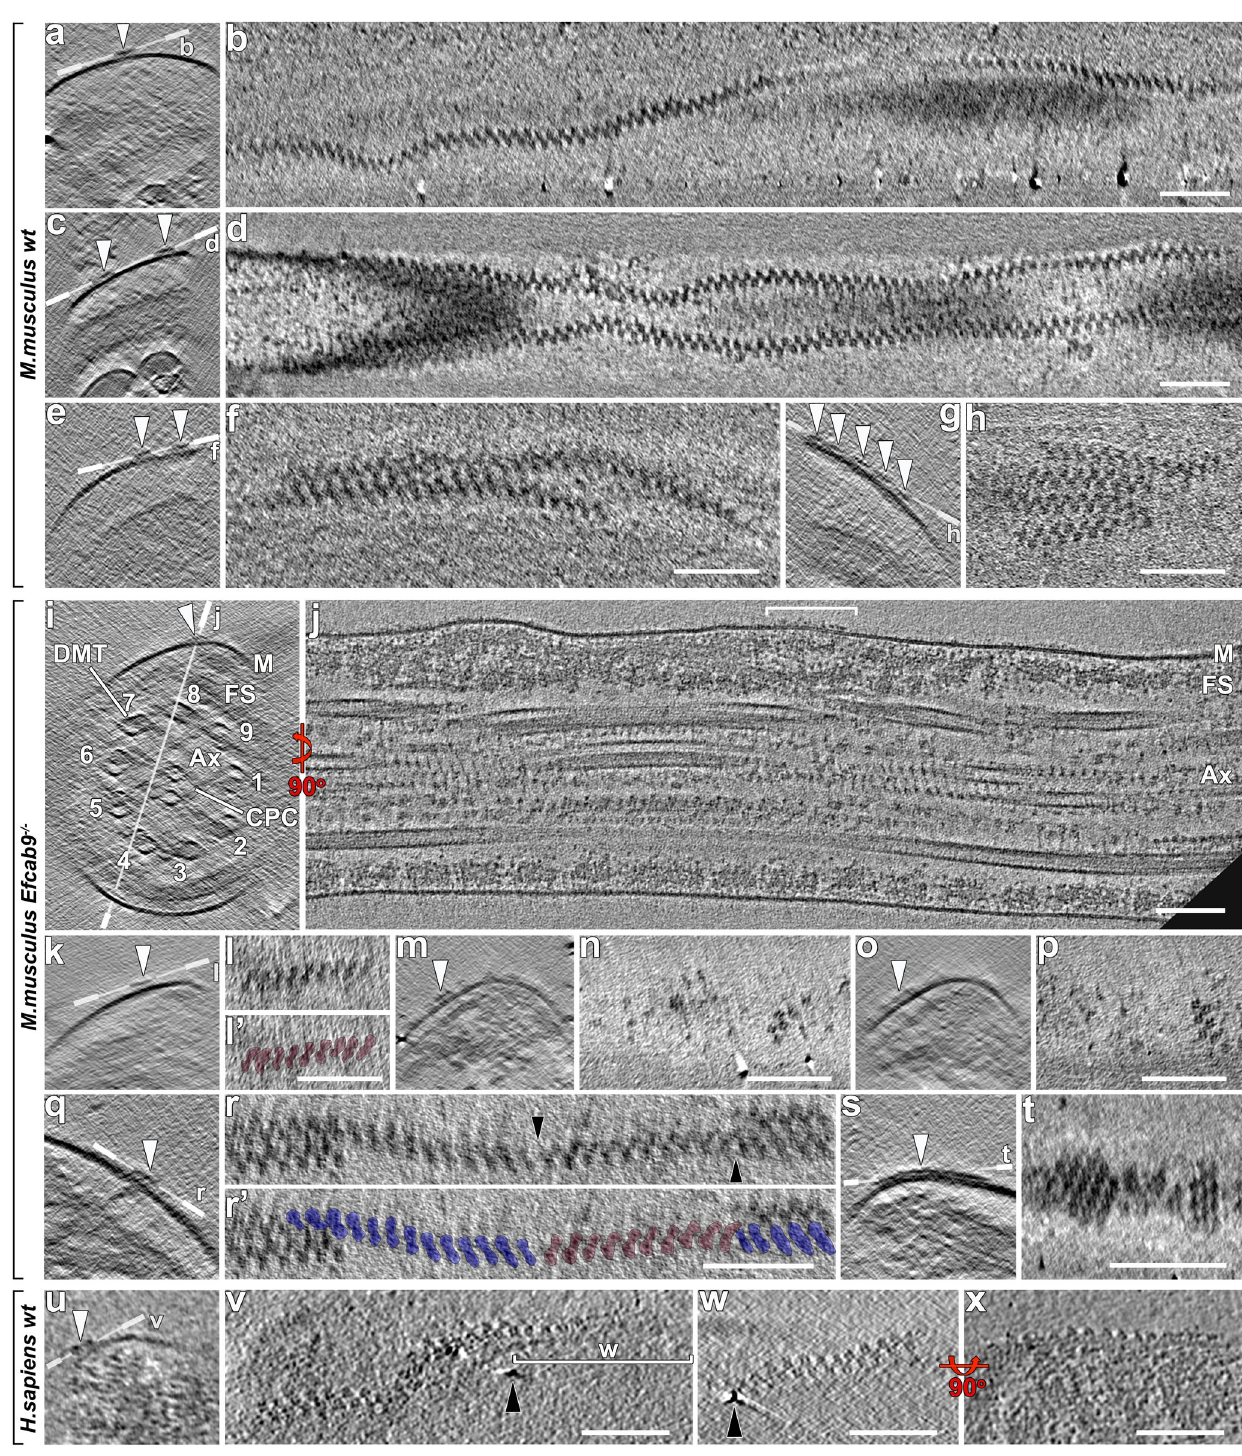
Fig. 2 In-cell structure of the native CatSper complexes in intact mammalian sperm fl agella. a – h Representative tomographic slices of the repeating CatSper channel complexes arranged in zigzag-rows along the longitudinal axis of wild type mouse sperm fl agella shown as cross-sectional ( a , c , e , g ) and top views ( b , d , f , h ). The number of zigzag-rows (arrowheads) varied from a single row ( a , b ), two rows ( c , d ), merging rows ( e , f ), to up to fi ve rows ( g , h ). i – j A representative principal piece region of a whole-cell (i.e., not cryo-FIB milled) Efcab9 − / − mouse sperm fl agellum (in non-capacitated state) viewed in cross- sectional ( i ) and longitudinal ( j ) tomographic slices. Labeled line in ( i ) indicates the position of the section shown in ( j ). Other labels: Ax axoneme, CPC central pair complex, DMT & 1-9 doublet microtubules, FS fi brous sheath, M membrane. k – t Representative tomographic slices from Efcab9 − / − sperm showing fragmented and short CatSper complex clusterswith altered orientation relative to the fl agellaraxis (cross section views: k , m , o , q , s ; top views: l . l ’ , n , p , r , r ’ , t ). Two distinct arrangements are pseudo-colored(backslash(\) blueand forward slash(/) pink) in( l ’ and r ’ ). Black arrowheadsin( r ) indicatetheinterruptions of the row. u – x Zigzag-arrangement of CatSper in a human sperm fl agellum shown in cross-sectional ( u ), top ( v , w ) and sideview ( x ). Black arrowheads in ( v and w ) indicate the same position between the two slices show at slightly different angles. Scale bars, 100